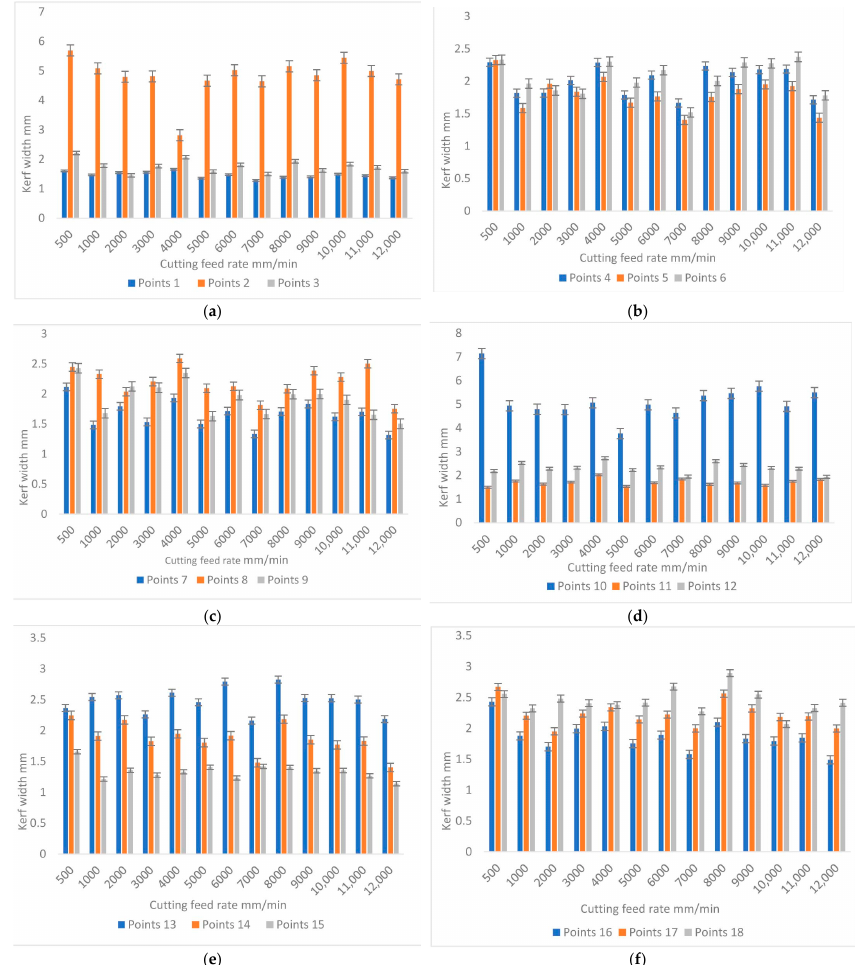
Figure 13. ( a – f ) Kerf width measurements at Points 1 to 18 on the cutting path from 500 to 12,000 mm/min for specimen numbers 1 to 13: ( a ) Points 1 to 3; ( b ) Points 4 to 6; ( c ) Points 7 to 9; ( d ) Points 10 to 12; ( e ) Points 13 to 15; ( f ) Points 16 to 18.